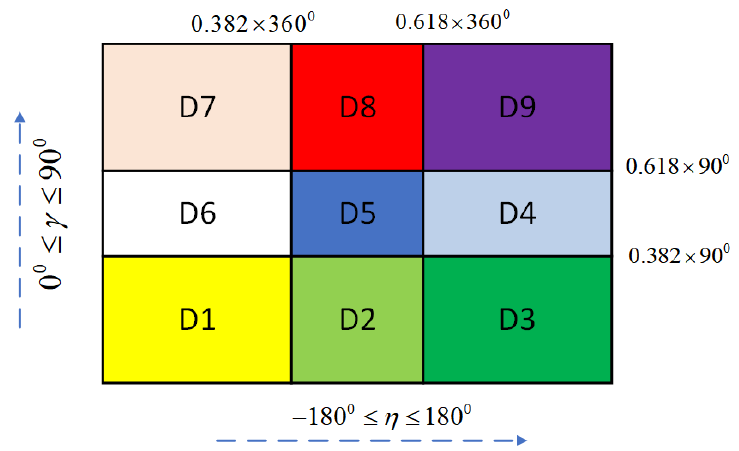
Figure 2. The divided areas in the